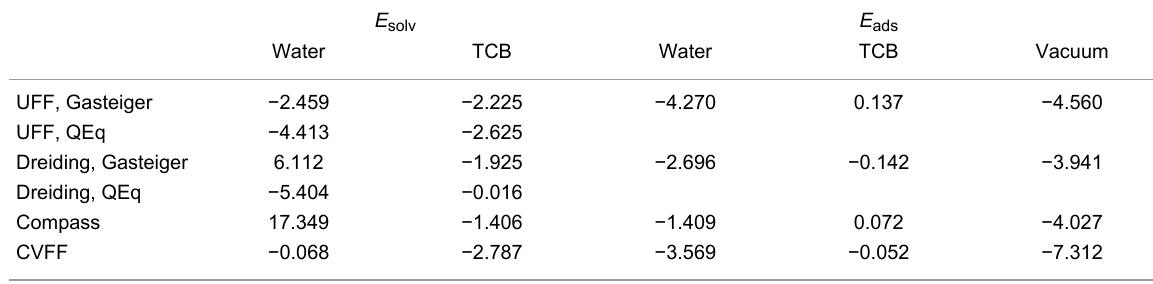
Table 1: Solvation ( E solv ) and adsorption ( E ads ) energies of 3,3 ′ -BTP in eV calculated using different force fields. E solv